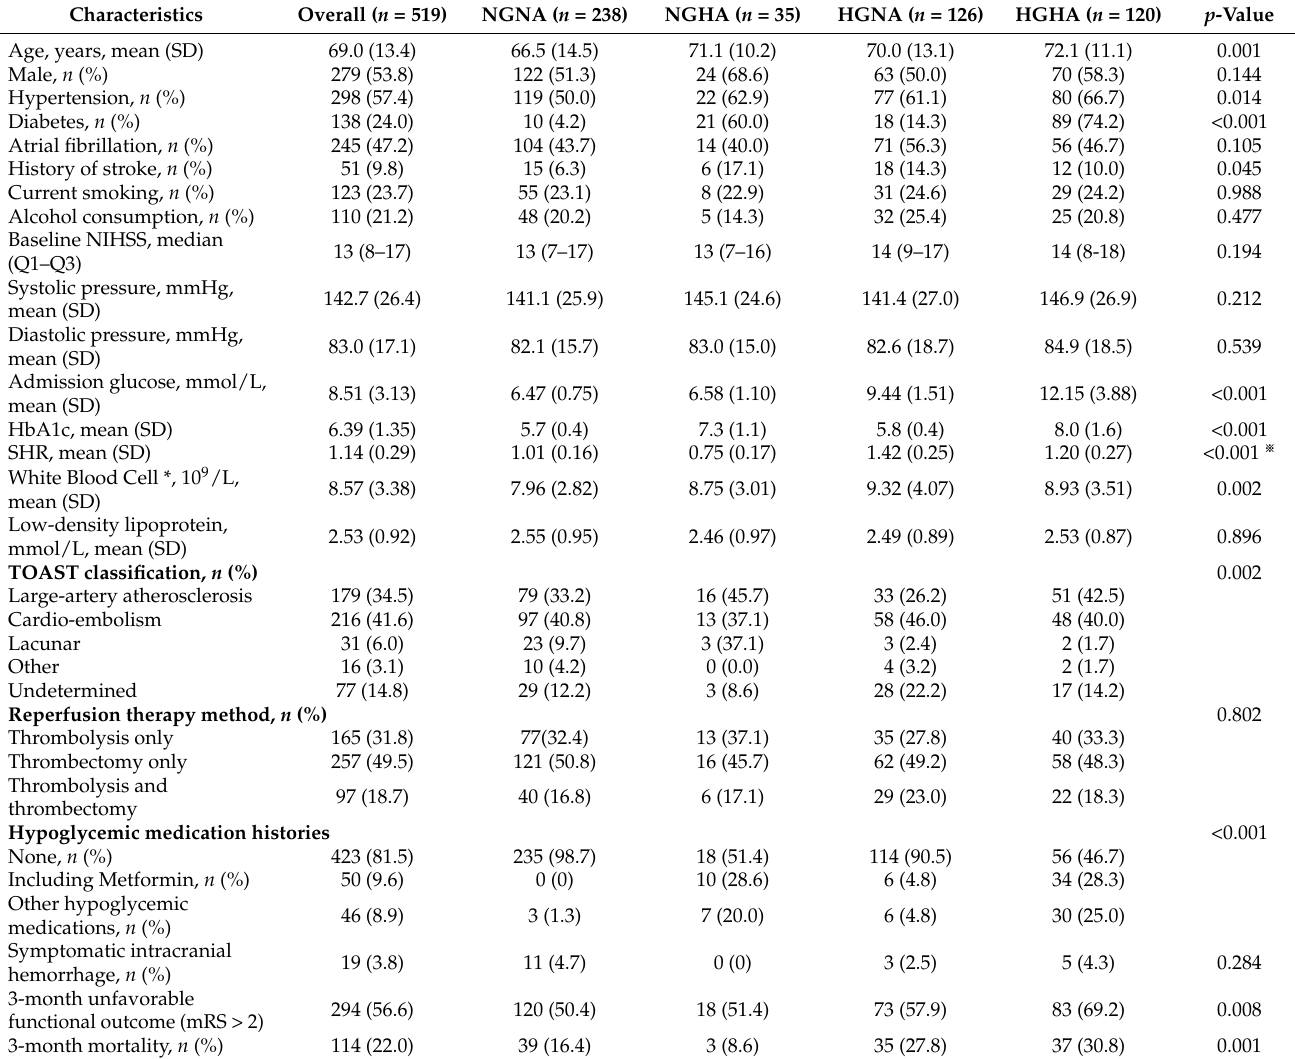
Table 1. Characteristics of patients according to admission glucose and HbA1c